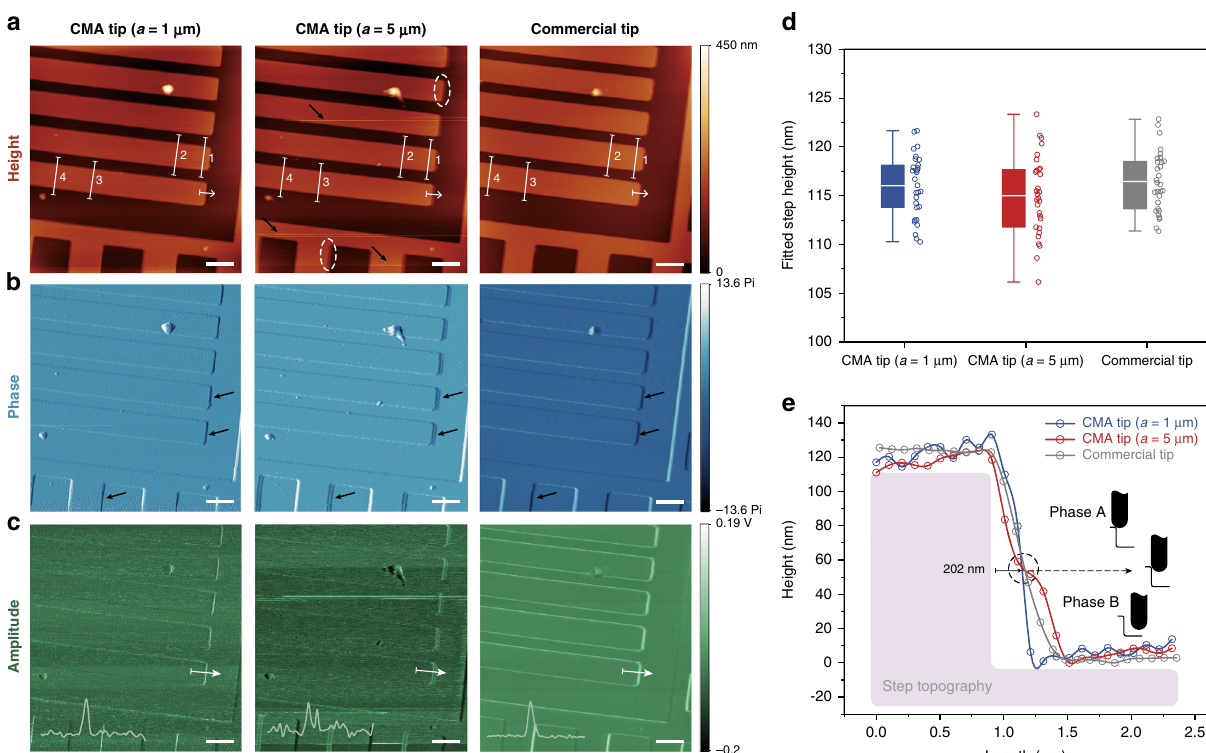
Fig. 3 AFM imaging of silicon microgrids with CMA tips. a – c AFM maps of height, phase and tuning fork amplitude by employing CMA tips ( a = 1 μ m and a = 5 μ m) and a commercial tip, respectively. The black arrows in a indicate the signal noise derived from unstable movement, while the black arrows in b show the imaging difference of the grid edges by different tips. The inset signal curves in c denote the amplitude voltage of the tuning fork when crossing the step edges (white arrowed lines). d Boxplot of step height acquired by the CMA tips and the commercial tip. The Boxplot marks the median (center line within box), the fi rst and third quartile (box), and 1.5 times the interquartile range (whiskers). The corresponding data are exhibited as scatters on the right side of each box. e Height pro fi le of the step pattern along the white arrow lines marked in a . The scanning processes of the tips are divided into two phases (Phase A and B) as sketched by the insets with transition point indicated by the dashed circle. All scale bars are 4 μ m for a – c . Source data of d , e are provided as a Source Data fi